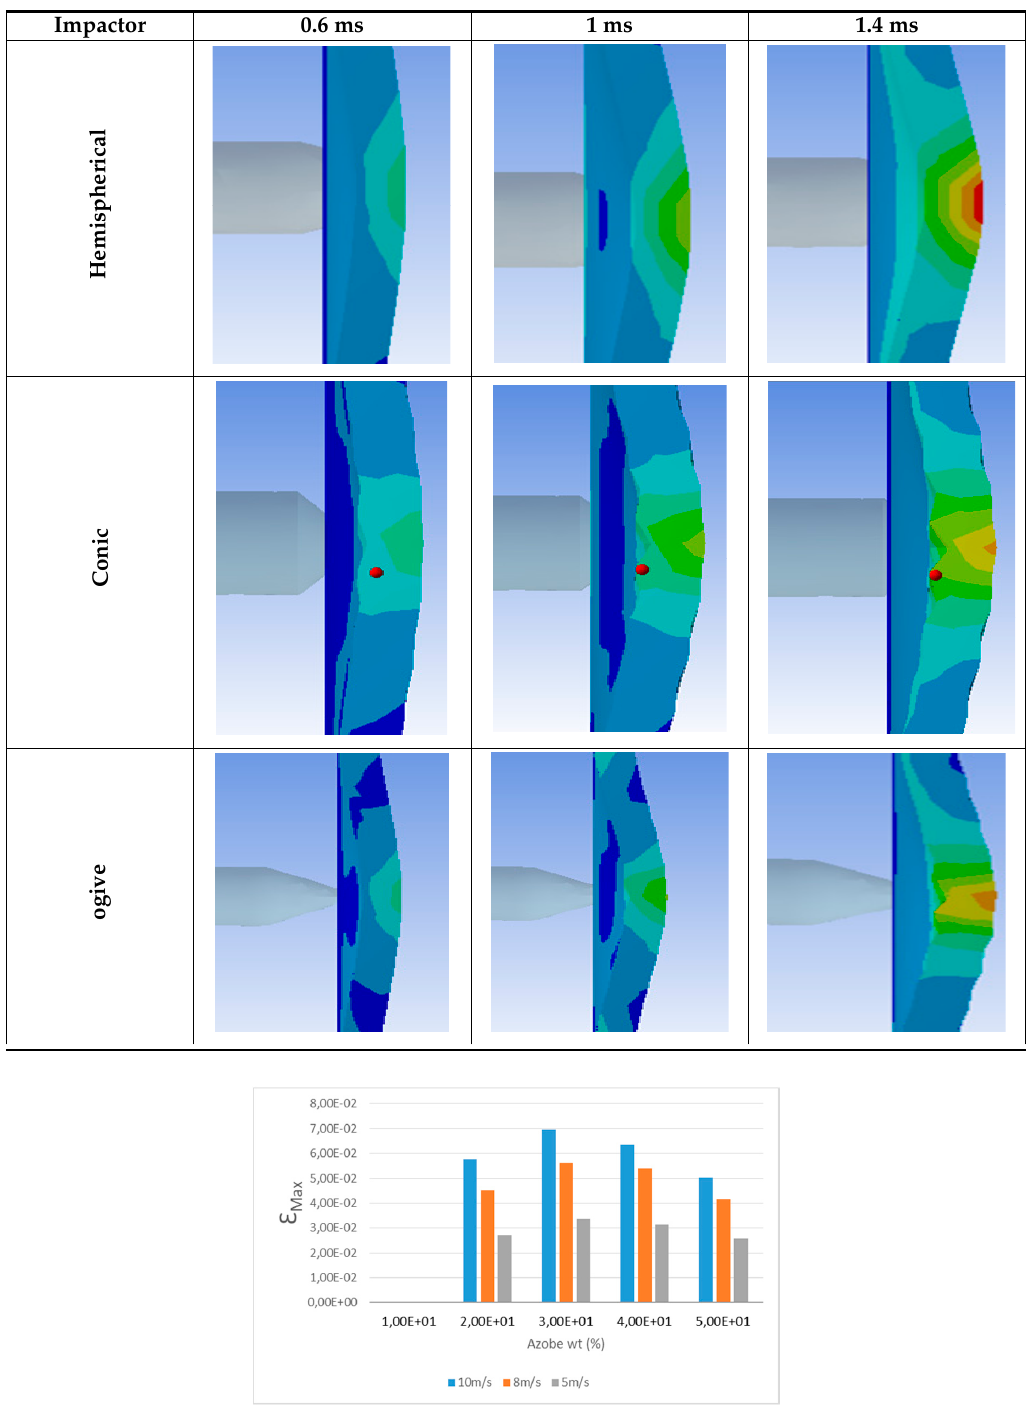
Figure 11. Equivalent stress at the center of the plate. Table 3. State of the deformations of the WPC50A composite plate observed at regular intervals of 0.4 ms for each type of impactor.